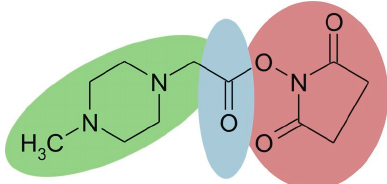
Figure 8. Chemical structure of the iTRAQ™ reagent. This figure is adapted from reference [61].